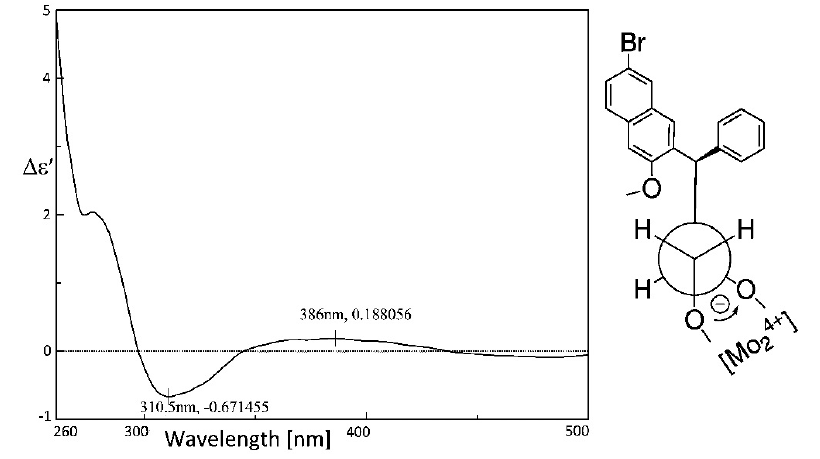
Figure 3 . Induced CD spectra of in situ formed Mo-complex of 10a . Figure 3. Induced CD spectra of in situ formed Mo-complex of 10a